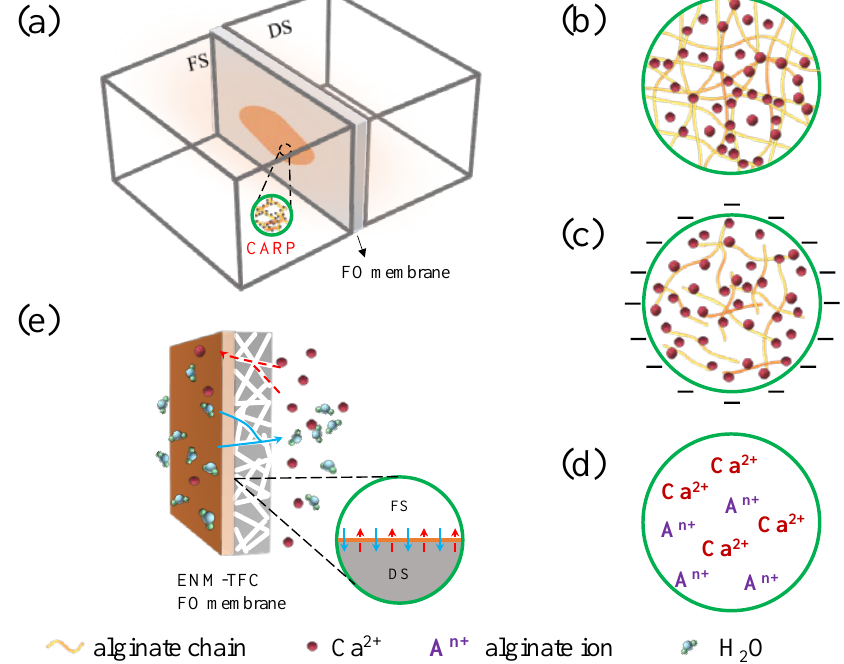
Figure 7. Schematic diagram of the mechanism analysis showing that Ca-Alg recovery production (CARP) affects the reverse diffusion of Ca 2+ in the draw solution (DS) in calcium alginate production via forward osmosis (FO) with alginate solution as the feed solution (FS). ( a ) CARP on the FO membrane in FO cell; ( b ) image of CARP with molecular sieve role; ( c ) electrification of CARP colloids; ( d ) ions in CARP contributing to osmotic pressure; ( e ) visualization of a thin film composite FO membrane with an electrospinning nanofiber membrane support layer (ENM-TFC FO membrane) regulating water and salt flux.